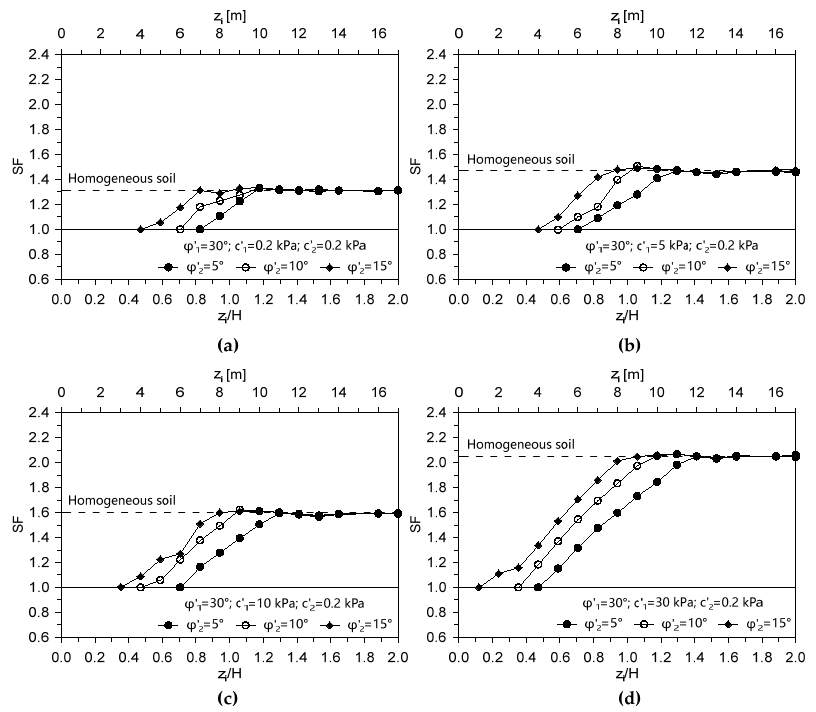
Figure 9. Safety factor SF as a function of the geometrical variable z i /H for φ′ 1 = 30° and c ′ 1 = 0.2 kPa ( a ), c ′ 1 = 5 kPa ( b ), c ′ 1 = 10 kPa ( c ) and c ′ 1 = 30 kPa ( d ), for different values of the shear strength angle φ′ 2 (5°, 10° and 15°).